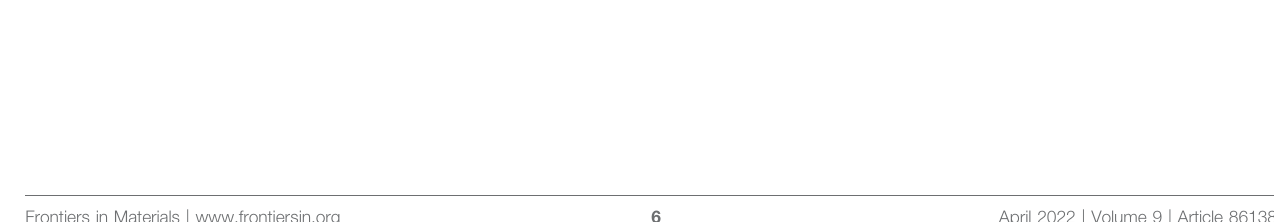
Frontiers in Materials |